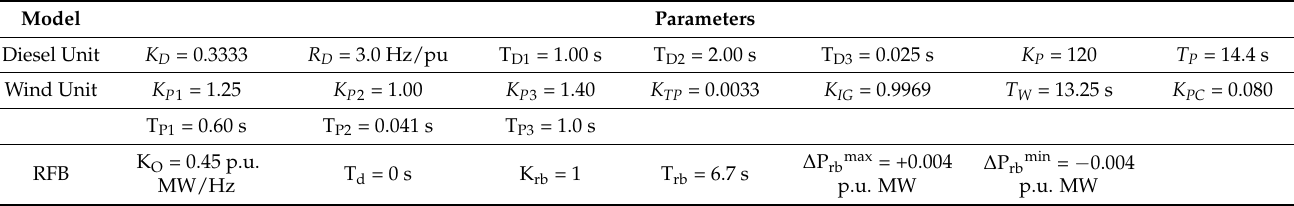
Table A1. Nominal system parameters of the diesel–wind model